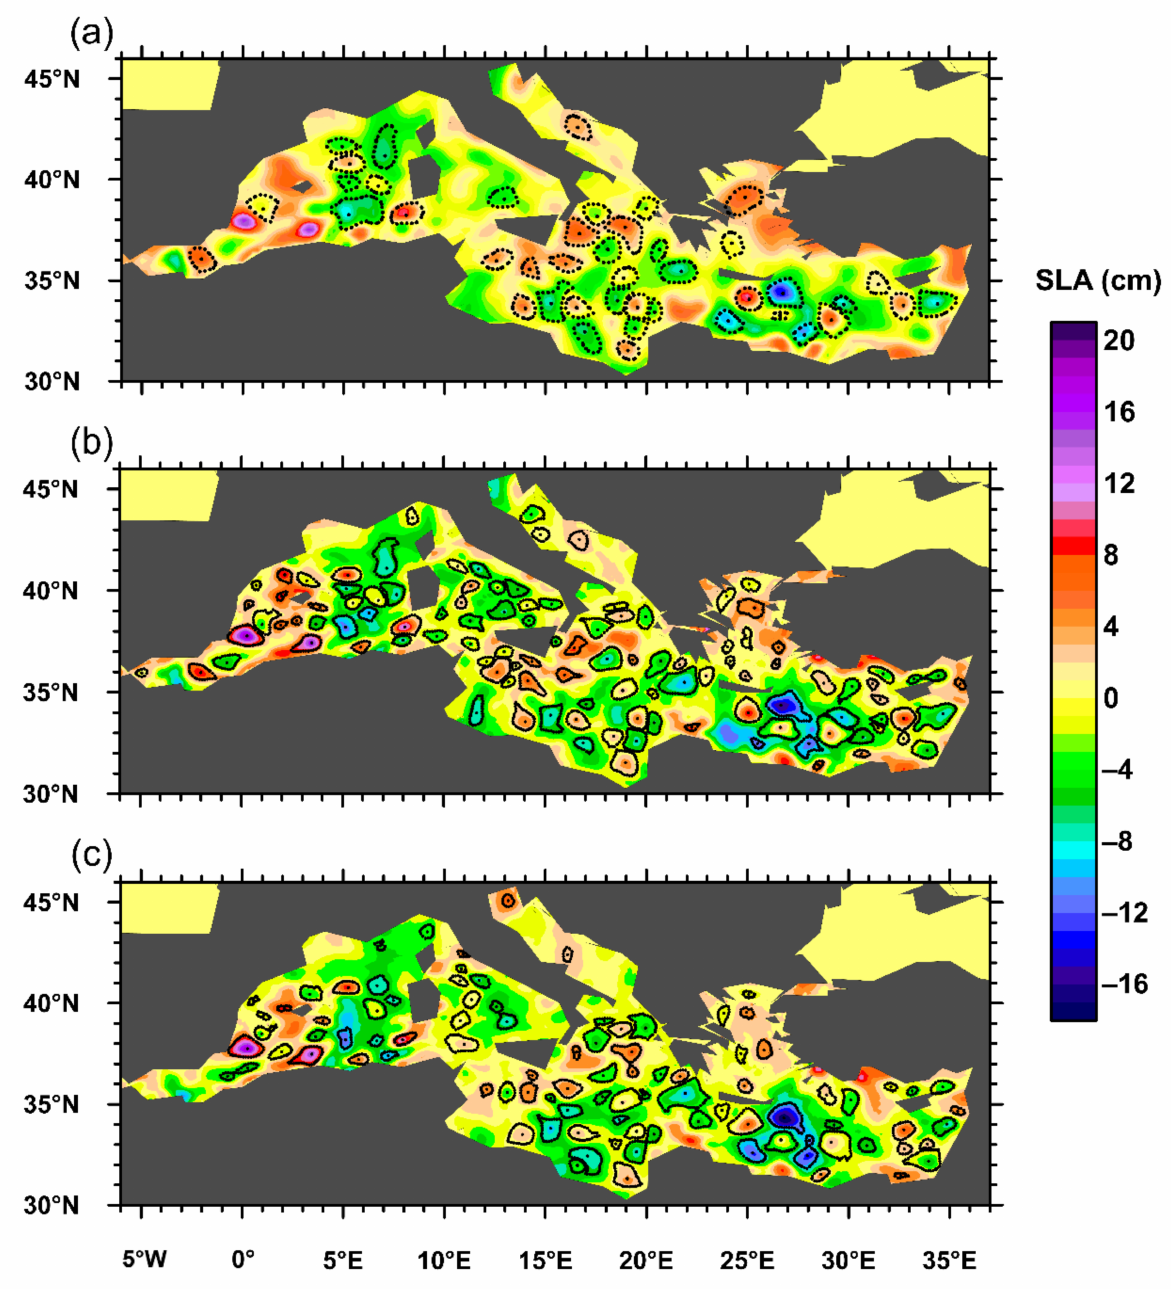
Figure 1. SLA (cm) and eddy identification results (eddy effect contour and eddy centroid core) of three datasets in the Mediterranean Sea: ( a ) 1/4 ◦ ; ( b ) 1/8 ◦ all-sat; ( c ) 1/8 ◦